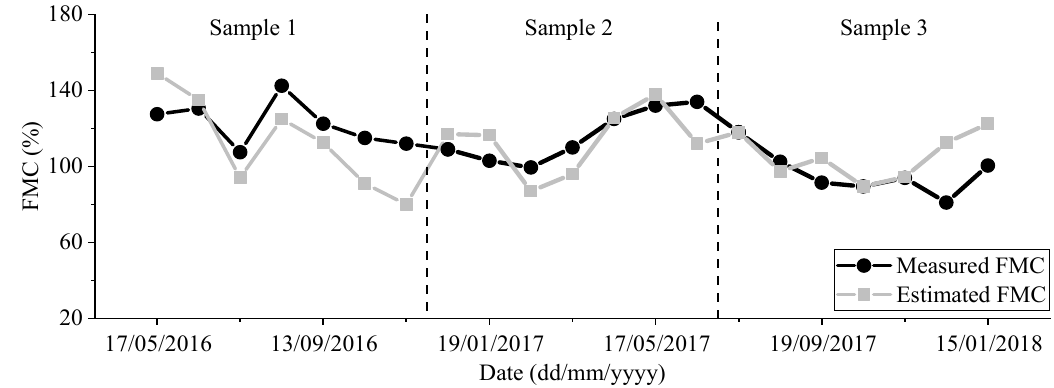
Remote Sens. 2019 , 11 , x FOR PEER REVIEW Figure 10. Scatterplots between estimated and measured FMC. Figure 10. Scatterplots between estimated and measured FMC.